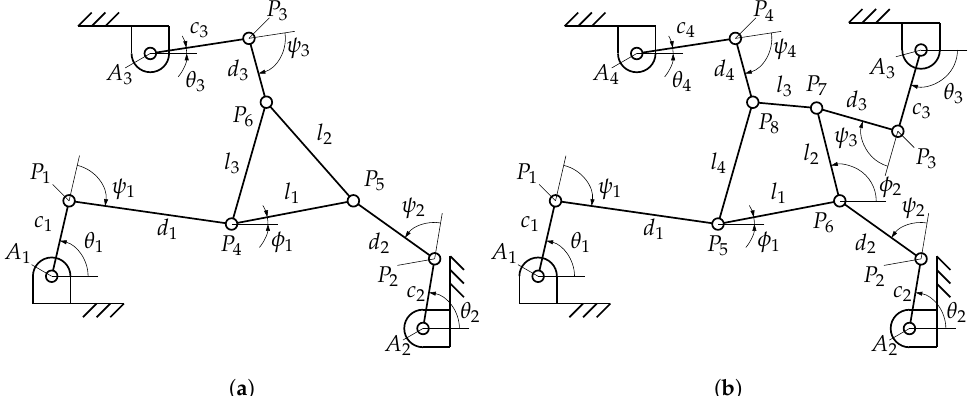
Figure A1. Schematics of: ( a ) a general 3-RRR robot; ( b ) a general 4-RRR robot. They have, respec- tively, 3 and 4